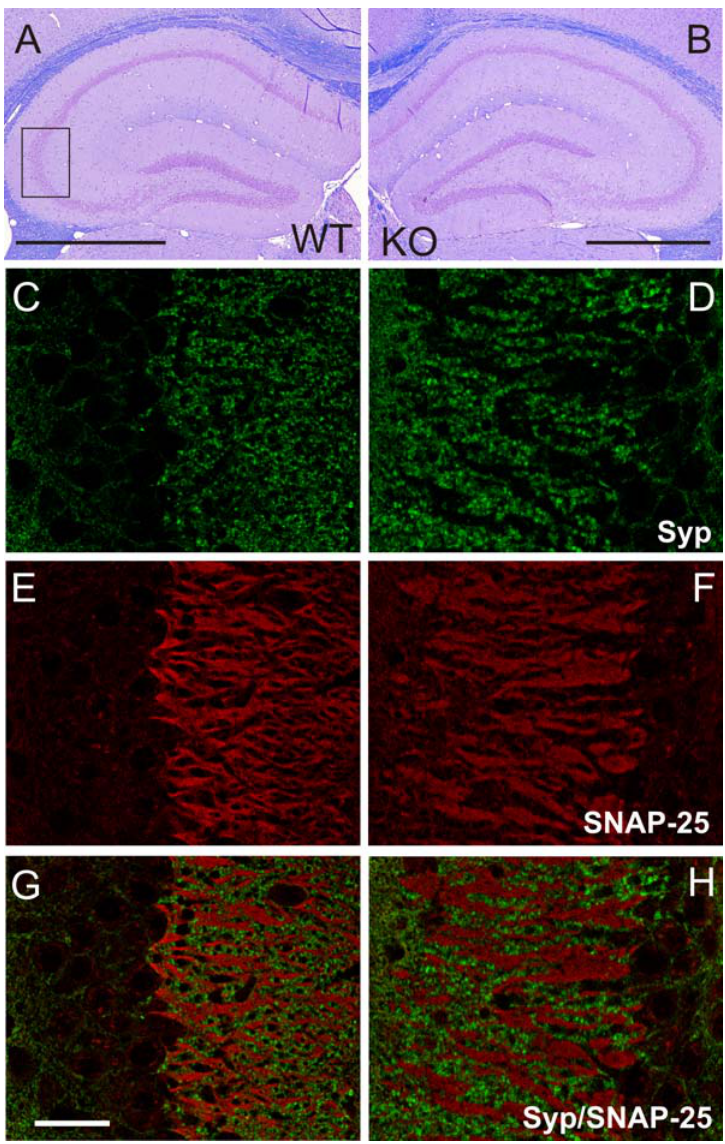
Figure 5. Brain Pathology Develops in Adult Neo -excised SNAP-25b Deficient Mice. (A–B) Cresyl violet stained coronal sections of adult WT (A) and neo -excised SNAP-25b deficient (B) mice at the level of the hippocampus. The box indicates the CA3 area that is shown at higher magnification in (C–H). Scale bars=1 mm. (C–H) Representative images of synaptophysin (green) and SNAP-25 (red) (E,F) immunoreactivity in the hippocampus of 4-month-old WT (left column) and neo -excised SNAP-25b deficient mutants (right column), and double immunofluorescence images (G,H). Scale bar=50 m m (n=3 animals of each genotype, each brain analyzed at least at three different levels).